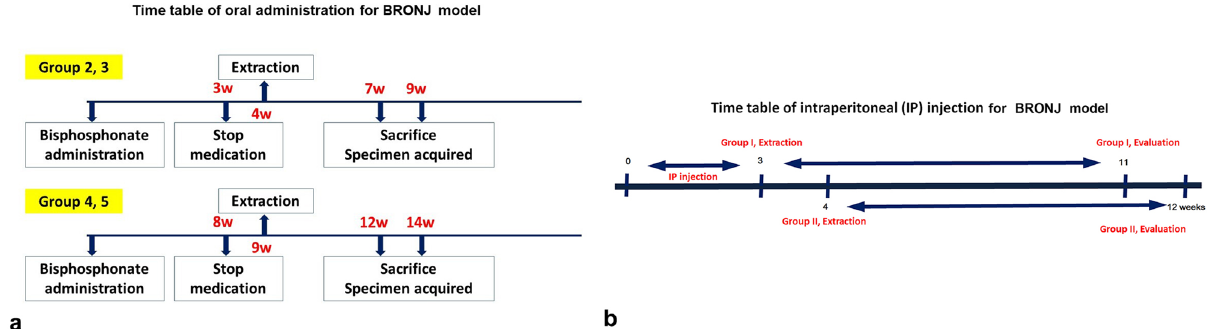
Figure 1. Schematic timetable for oral administration ( a ) and intraperitoneal injection ( b ) with the period of medication discontinuation in this animal